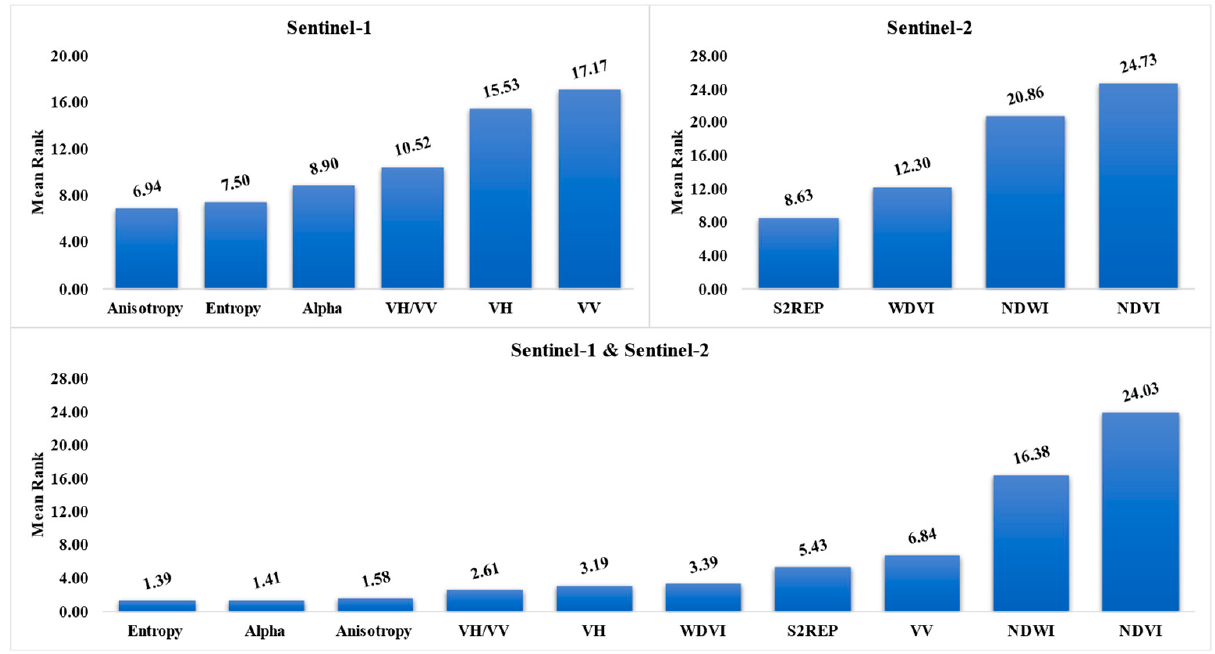
Figure 9. Mean rank of importance of different parameters and indices.